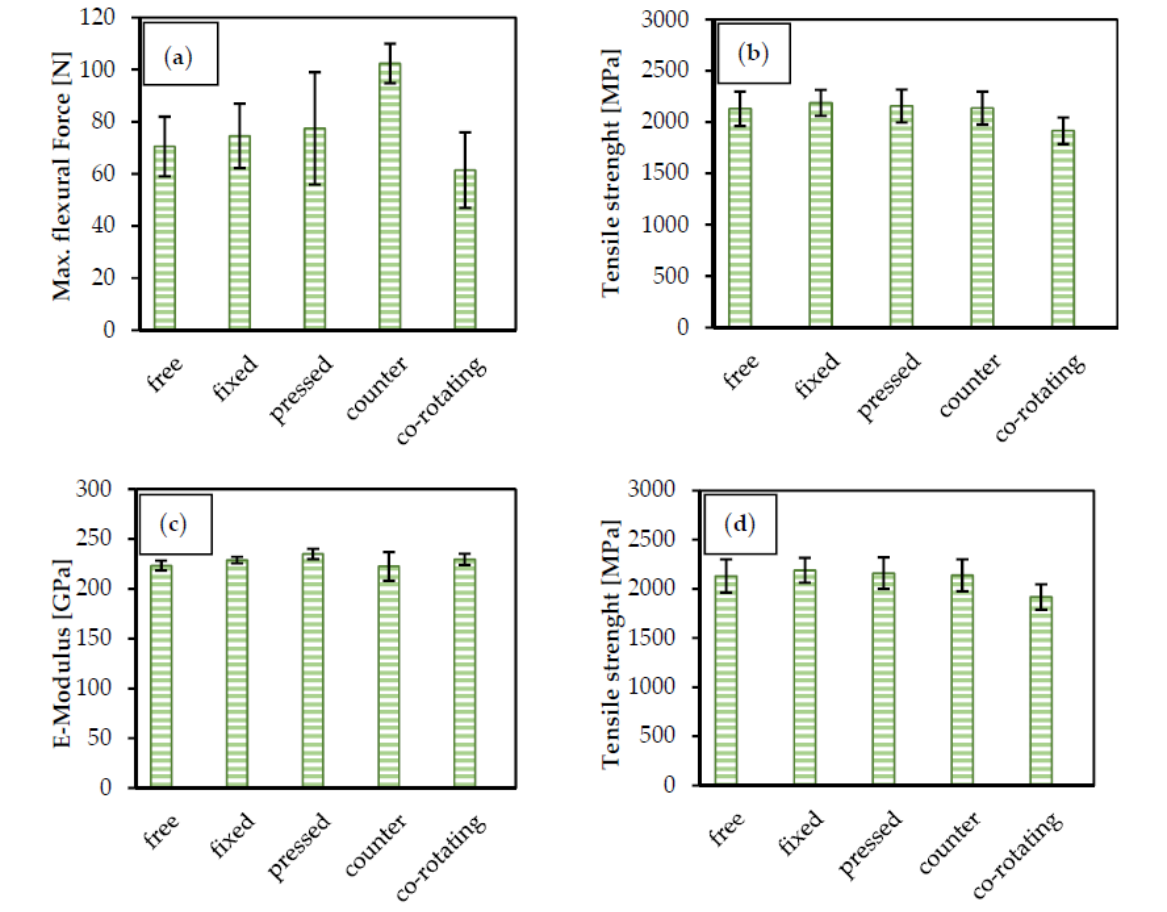
Figure 14. ( a ) Maximum flexural force; ( b ) uniaxial tensile strength; ( c ) E-modulus; and ( d ) elongation at rupture of MCFs produced with varied roller rotation configurations.